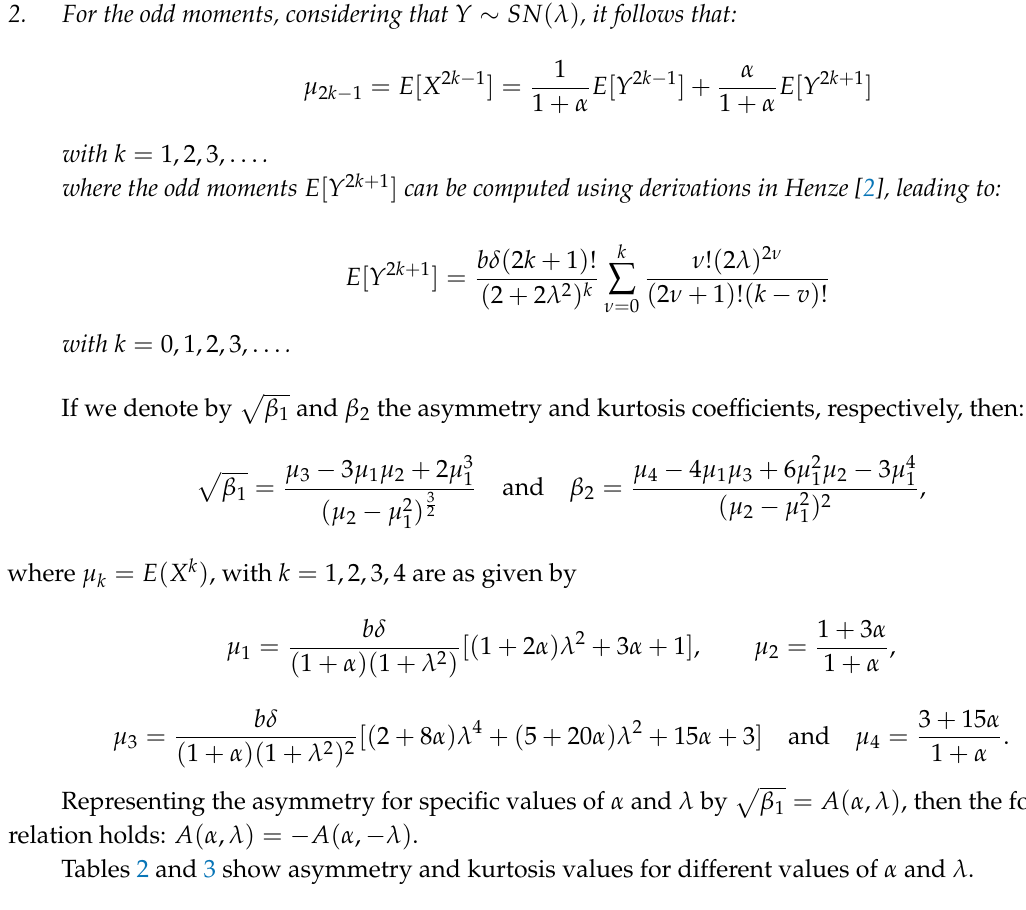
Table 2. Possible values of the standardized skewness